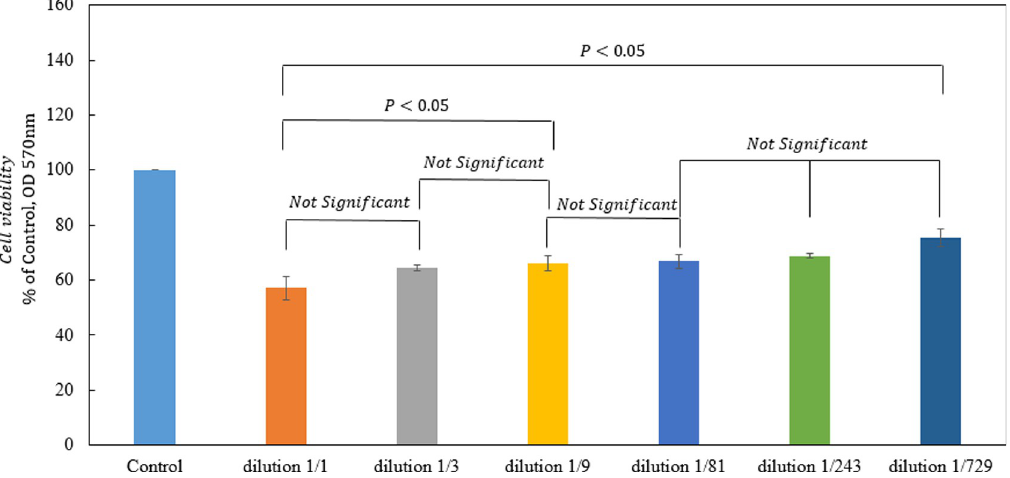
Fig 11. Three independent determinations of cellular viability by MTT assay. Comparison of percentage of viability of cells exposed to 1:3, 1:9, 1:27, 1:81, 1:243, and 1:729 dilutions of UDA.